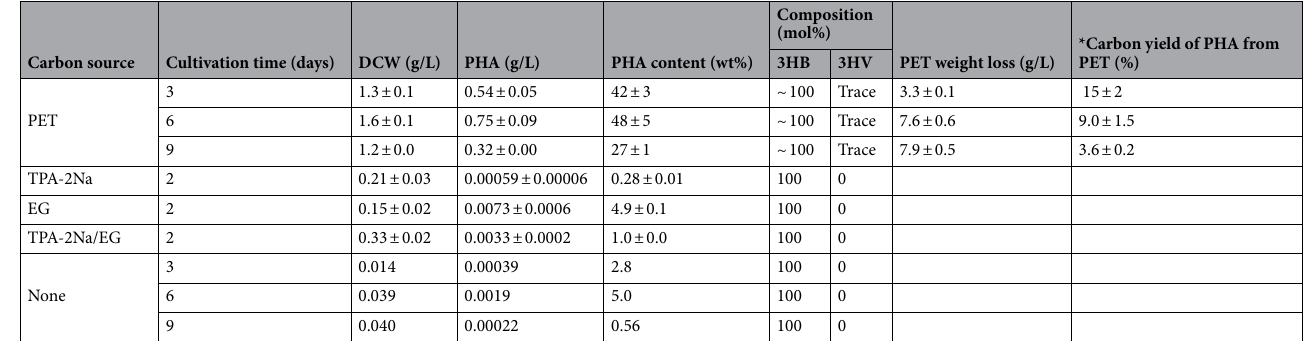
Table 1. PHA biosynthesis by Ideonella sakaiensis . Error bars represent the standard error among three independent biological replicates. DCW dried cell weight, EG ethylene glycol, ND not detected, PET poly(ethylene terephthalate), PHA poly(hydroxyalkanoate), TPA-2Na disodium terephthalate, 3HB 3-hydroxybutyrate, 3HV 3-hydroxyvalerate. *Calculated as [(carbon weight of PHA produced with PET— carbon weight of PHA produced without PET)/carbon weight in degraded